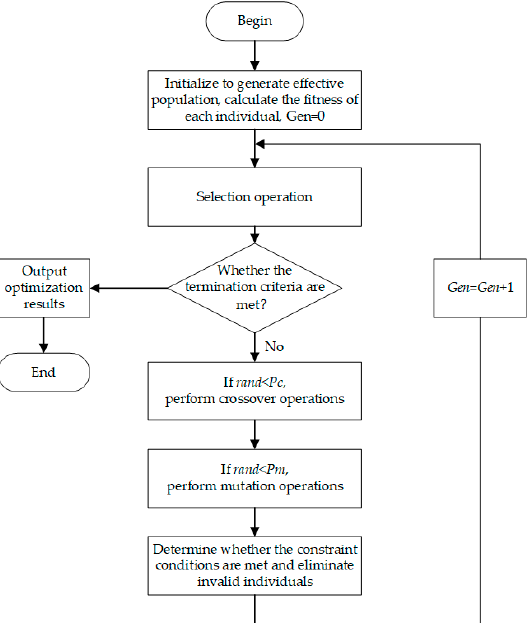
Figure 7. Operational flowchart of the AGA.